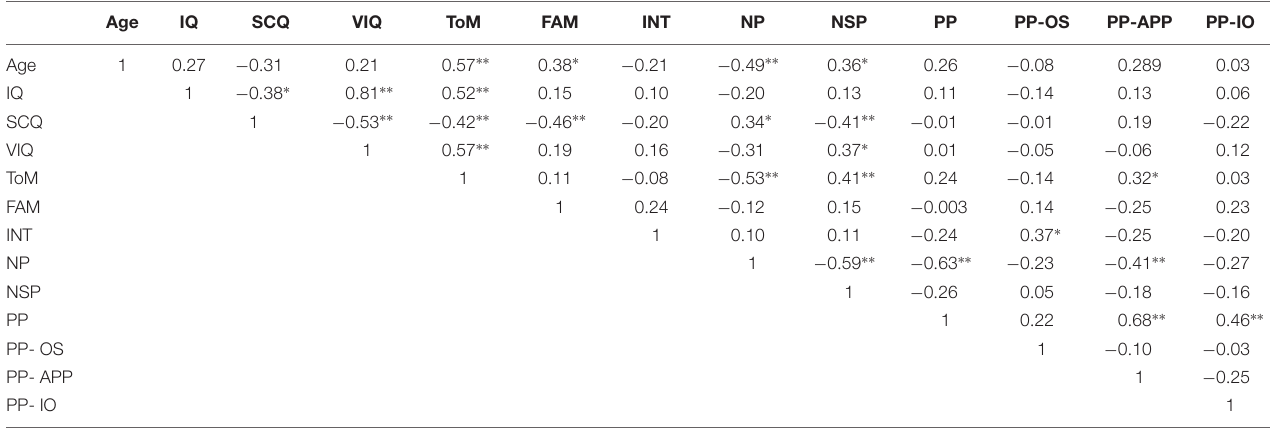
TABLE 2 | Correlations among continuous variables.